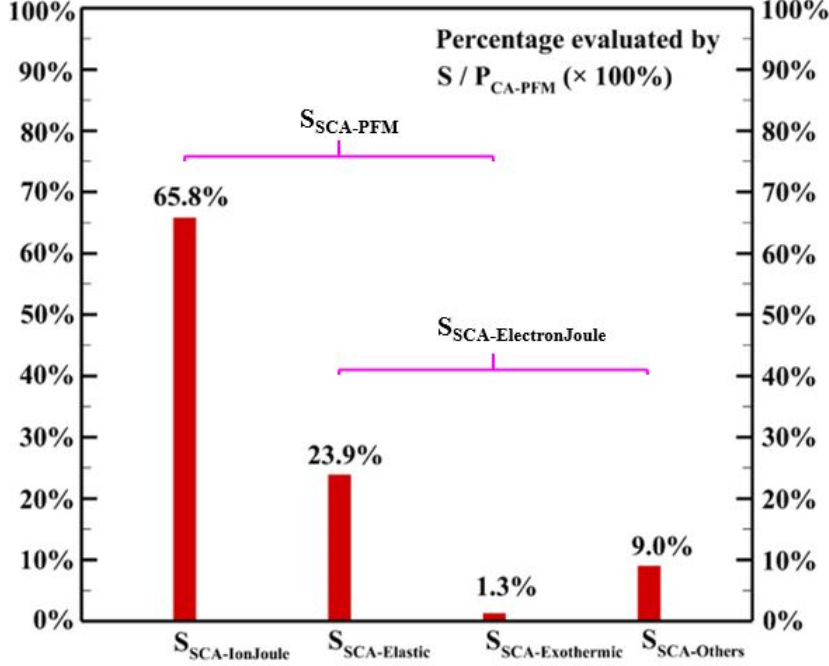
Figure 10. The simulated spatial cyclic average power consumption of different mechanisms.